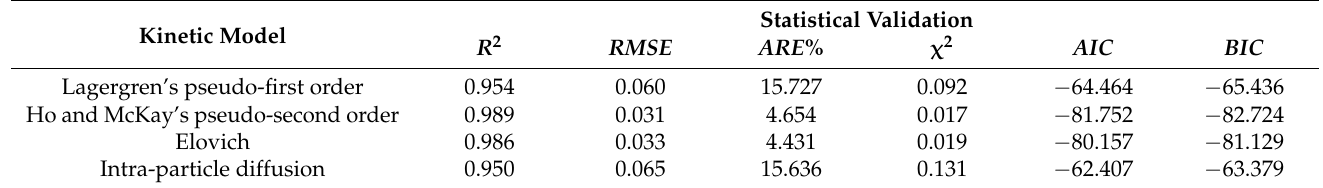
Table 1. Non-linear kinetic parameters with the correction coefficients for thymol adsorption on ZnLHS.